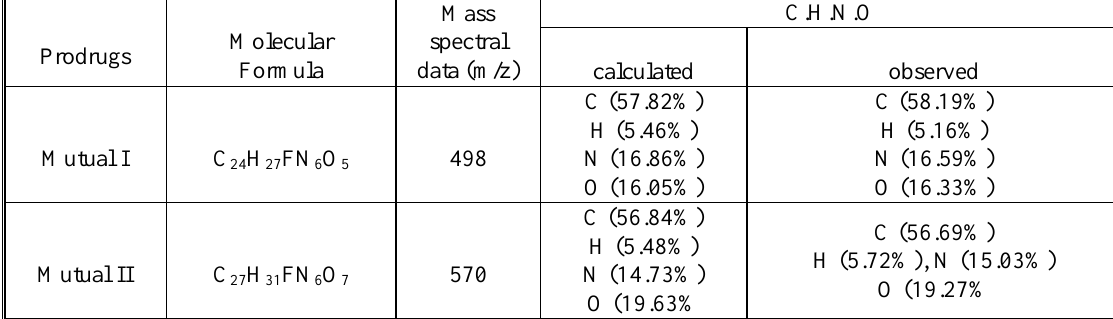
Scanning drugs and prodrugs